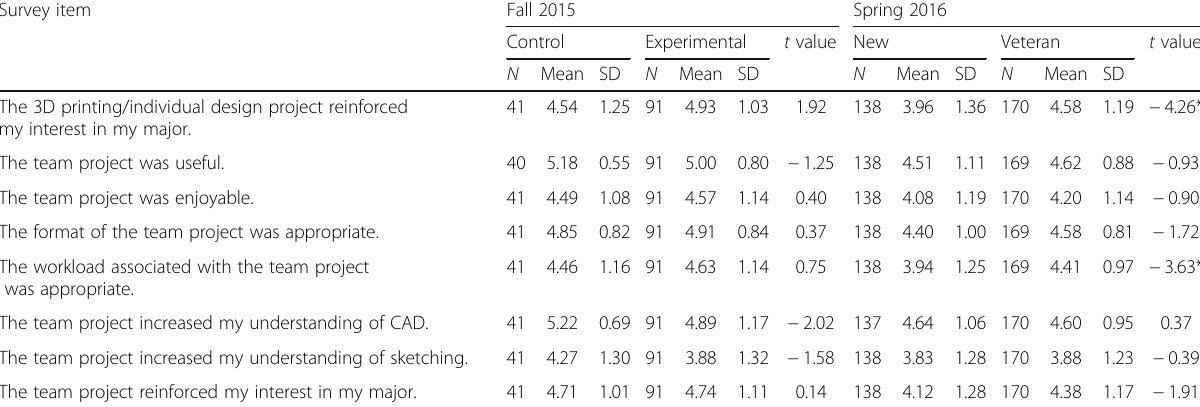
Table 2 End of semester survey results (Fall 2015 and Spring 2016) (Continued) Survey